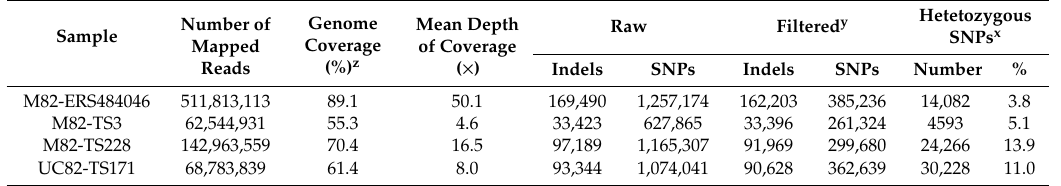
Table 2. Whole genome sequence alignment and variant calling relative to tomato reference